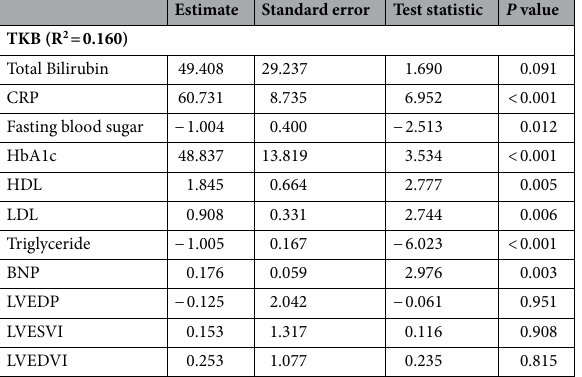
Table 4. The results of path model (B). R 2 squared multiple correlation, TKB total ketone body, CRP C-reactive protein, HDL high-density lipoprotein cholesterol, LDL low-density lipoprotein cholesterol, BNP B-type natriuretic peptide, LVEDP left ventricular end-diastolic pressure, LVESVI left ventricular end-systolic volume index, LVEDVI left ventricular end-diastolic volume